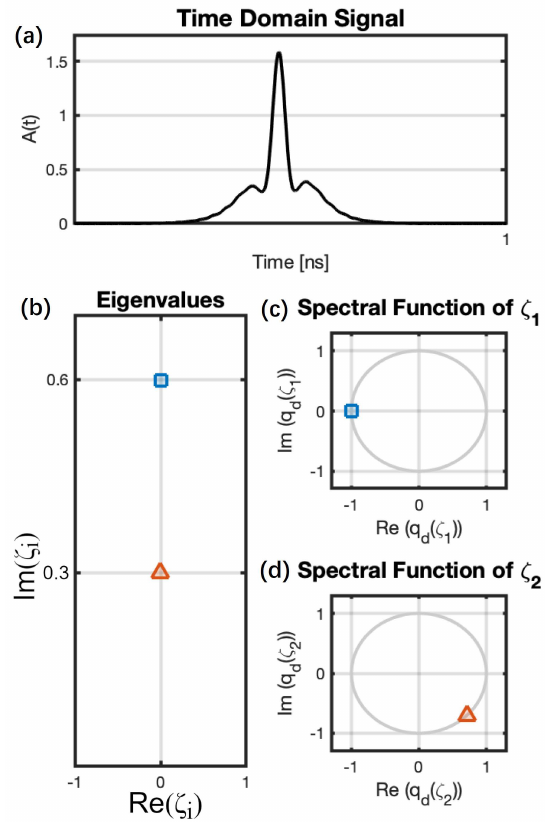
Figure 1. Single symbol representation: ( a ) Time domain representation of the second-order soliton. ( b ) Eigenvalues represented in the complex plane. Blue square used for ζ 1 = 0.6 j and red triangle for ζ 2 = 0.3 j . ( c , d ) the spectral function of the respective ζ j , in which the QPSK data is encoded. The algorithms for the NFT and the inverse NFT (INFT) are based on the Ablowitz- Ladik method and the Darboux transform, respectively [57]. We use the Ablowitz-Ladik method combined with the Newton-Raphson method to recover the eigenvalues ζ j and their respective encoded spectral functions q d ( ζ j ) at the receiver. The waveform is gen- erated at the transmitter from the eigenvalues and the spectral functions using the Dar- boux